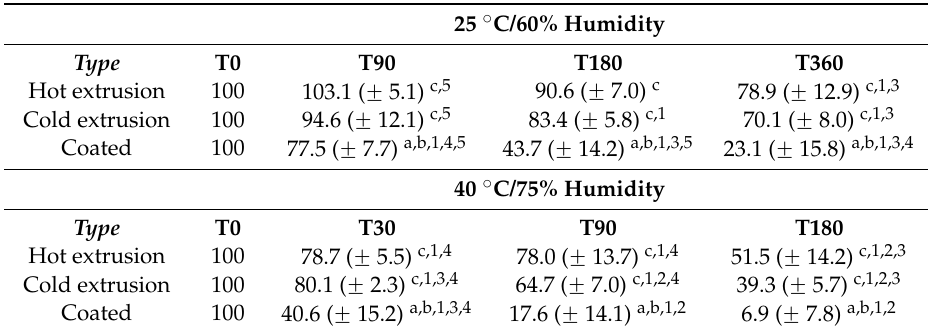
Table 2. Retention of retinyl palmitate over time, as percentage from retinyl palmitate concentration in uncooked fortified rice prior to storage (T0).